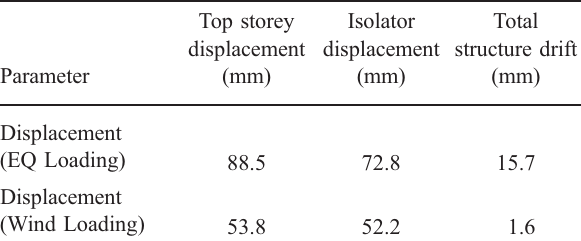
Table 4. Free vibration analysis result (isolated building) Table 2. Static analysis results (isolated base building)